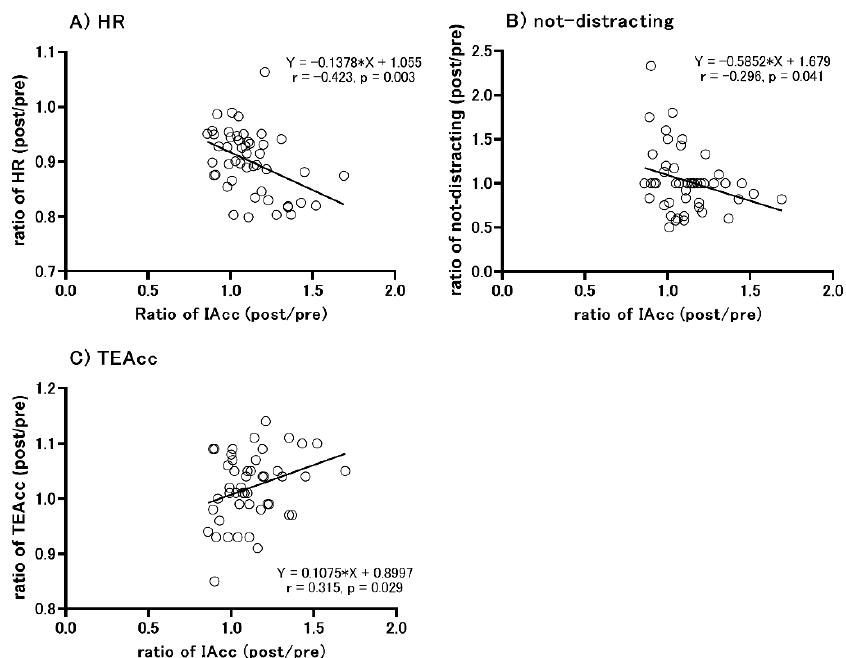
Figure 6. Correlation between the change in the ratio of interoceptive accuracy (IAcc) and other parameters. The x-axis is the difference in the ratio of IAcc (post-water immersion (WI)/pre-WI). The y-axis is the difference in HR ( A ), not-distracting in the Multidimensional Assessment of Interoceptive Awareness (MAIA) ( B ), and time estimation accuracy (TEAcc) ( C ). Not-distracting indicates the tendency not to ignore or distract oneself from sensations of pain or discomfort.